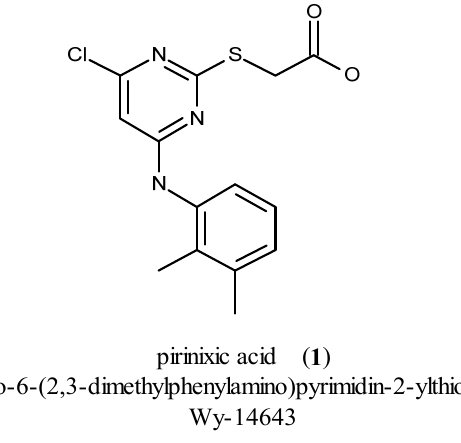
Figure 1. Chemical structure of pirinixic acid.